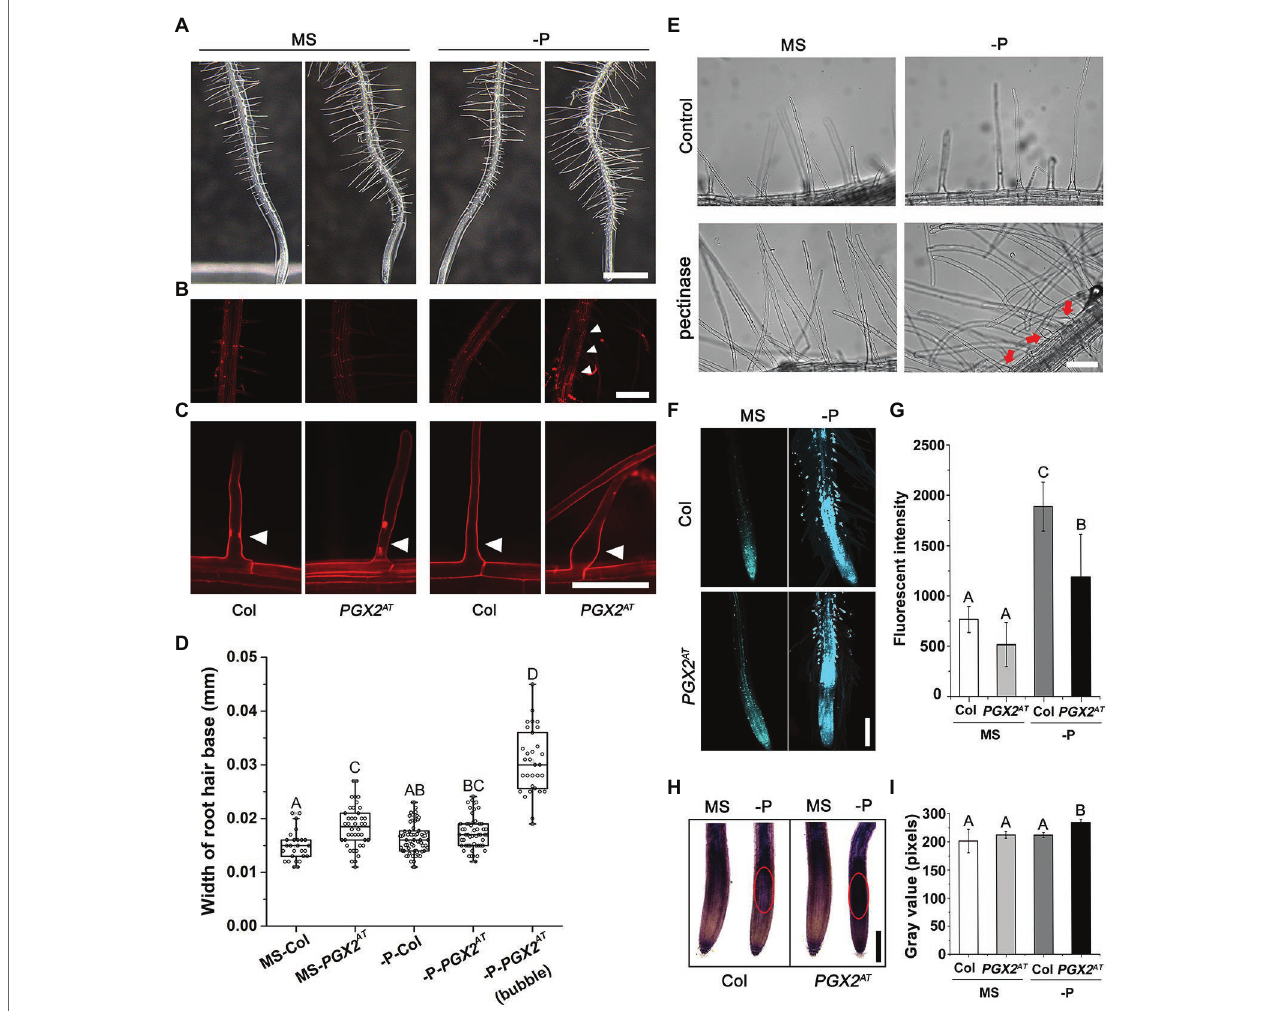
FIGURE 1 | Root hairs of PGX2 activation tag ( PGX2 AT ) seedlings are sensitive to low phosphate conditions. (A) Primary roots with root hairs of 7-day-old Col and PGX2 AT seedlings grown in ½ MS medium plates under normal (MS) and phosphate deficient (-P) conditions. Three-day-old seedlings were transferred from normal MS plates into normal MS or -P conditions for another 4 days. Images were taken on the 4th day after seedling transfer. Bar = 1 mm. (B) Zoomed in images from (A) focusing on root hair regions by PI staining. Bar = 200 μ m. (C) PI staining of root hairs in Col and PGX2 AT seedlings. Red and white arrowheads indicate positions of root hair bases. Bar = 0.1 mm. (D) Widths of root hair bases in Col and PGX2 AT seedlings grown in normal MS or -P conditions ( n ≥ 27 root hairs). (E) Pectinase treatment of Col seedlings after transferring to normal MS or -P conditions to grow for 4 days. Red arrows indicate bubble-like root hair bases. Bar = 100 μ m. (F) Aniline blue staining for callose in roots of Col and PGX2 AT seedlings. Images were taken on the 4th day after seedling transfer. Bar = 200 μ m. (G) Arbitrary fluorescent intensity of images for aniline blue staining ( n = 10 seedlings per each genotype). (H) NBT staining for superoxide in root tips of Col and PGX2 AT seedlings. Red circles show highly stained regions. Images were taken in the 4th day after seedling transfer. Bar = 200 μ m. (I) Gray value of NBT color intensity ( n = 10 seedlings per each genotype). Error bars represent SD. Uppercase letters indicate significantly different groups as determined by one-way ANOVA with post- hoc Duncan’s test ( p <